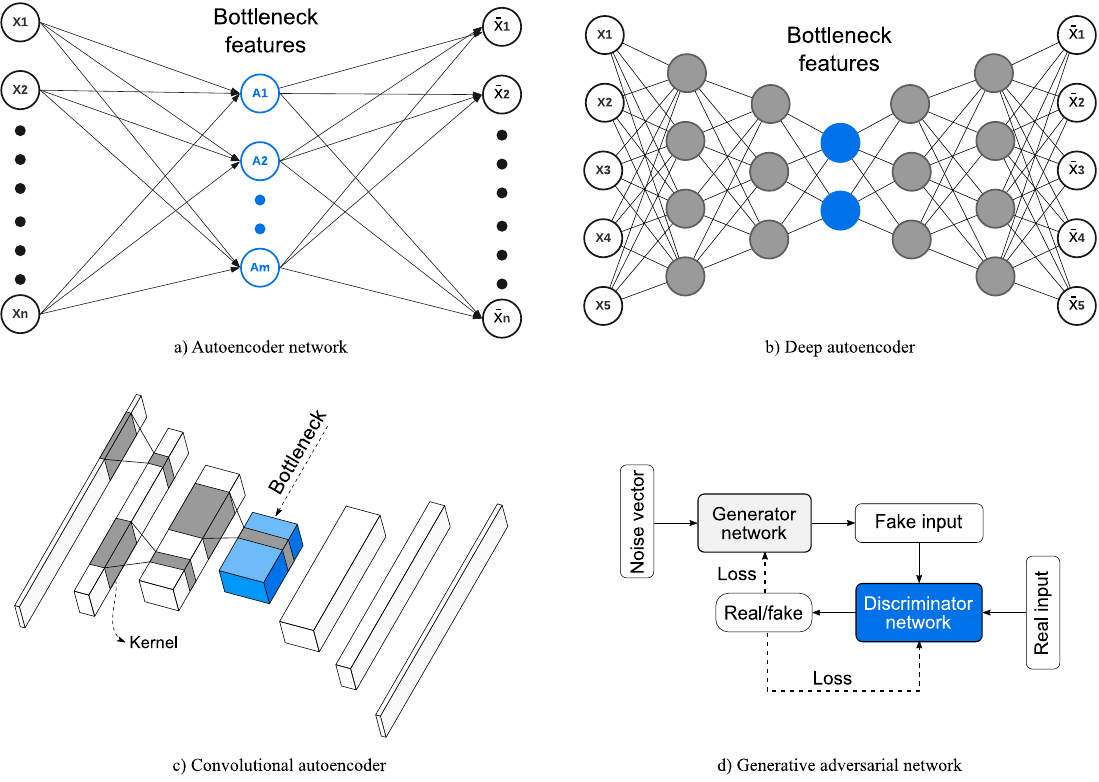
Figure 13. Examples of neural networks used in unsupervised SHM